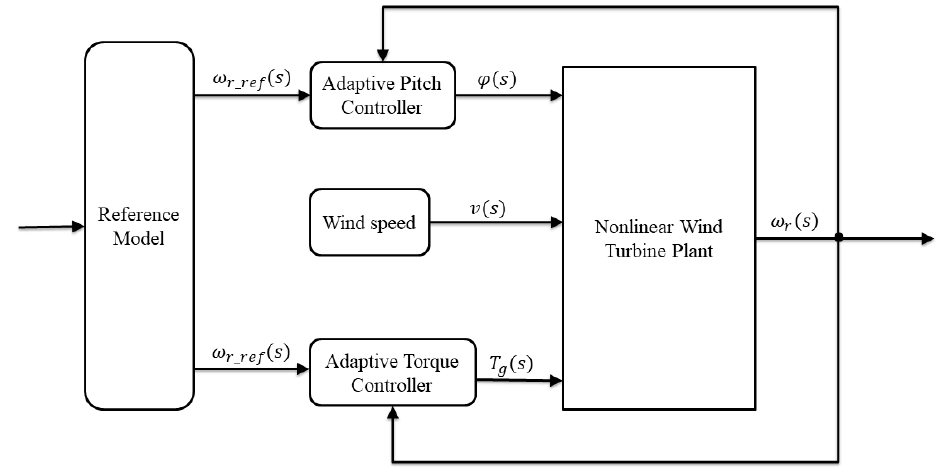
Figure 4. Wind turbine adaptive controller block diagram.